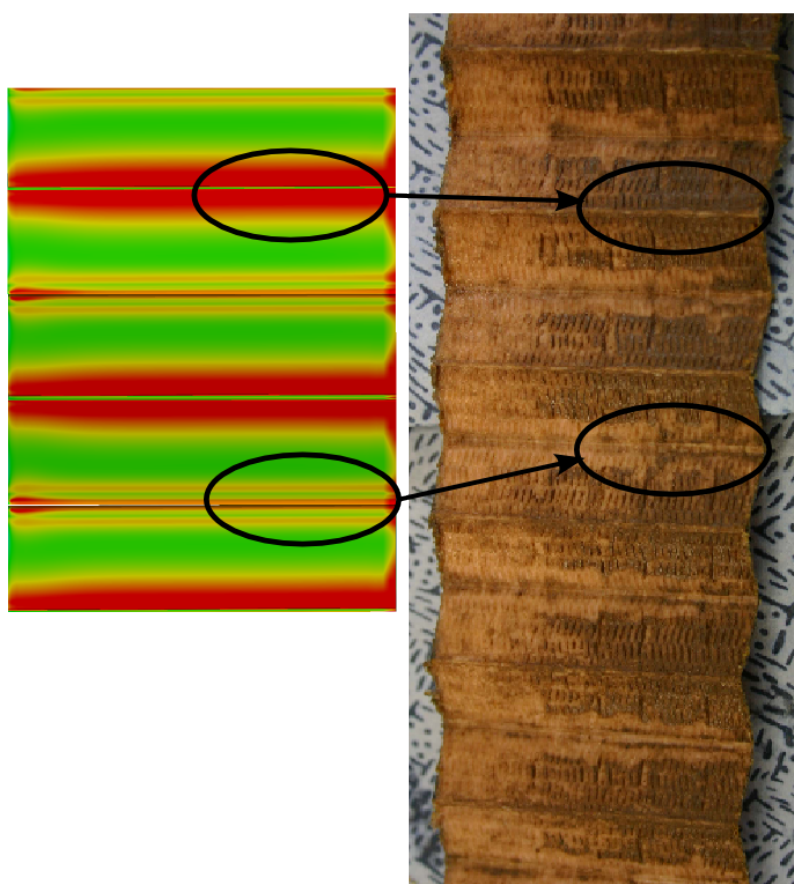
Figure 4. Unfolded view of a typical stained filter and comparison with numerical